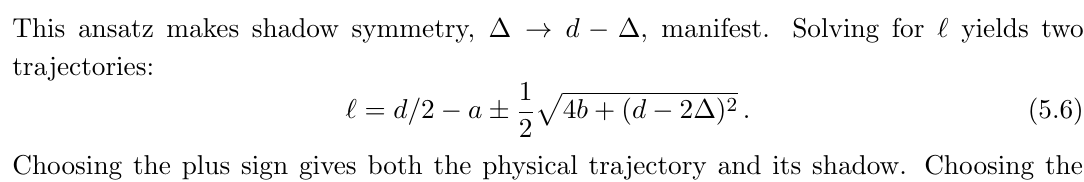
Figure 17 . The [ (cid:30)(cid:30) ] 0 + Regge intercept as a function of 1 =p max 0